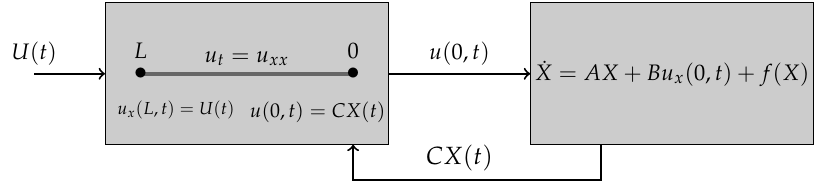
Figure 1. The block diagram of the coupled PDE-ODE system